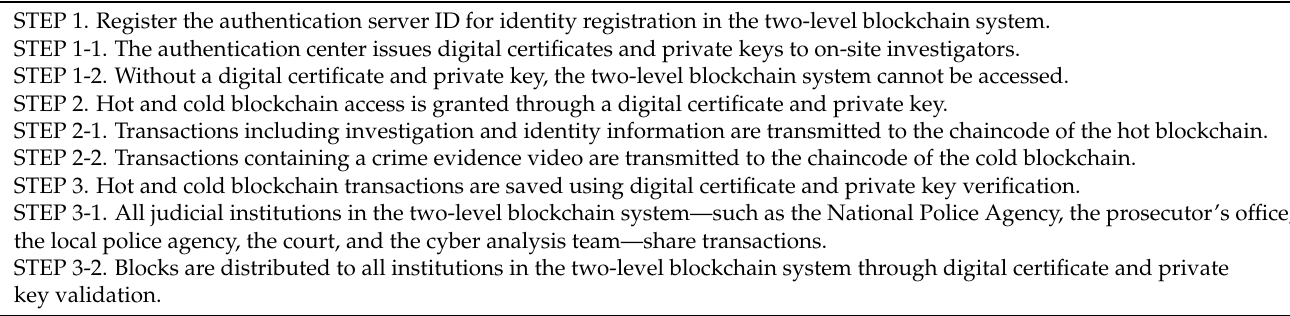
Table 2. Process of the two-level blockchain